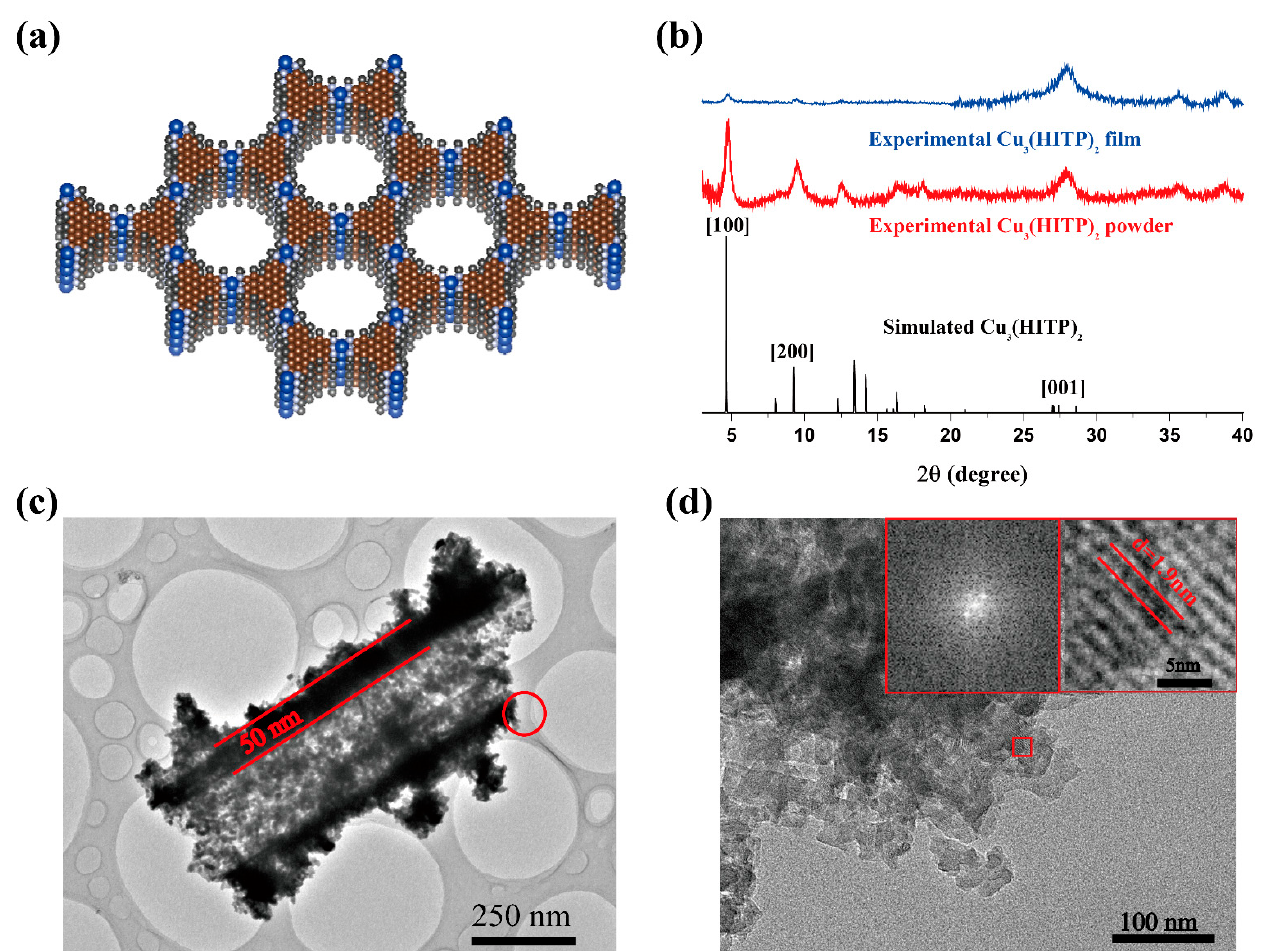
Figure 4. ( a ) Structure of Cu 3 (HITP) 2 viewed down the c-axis (brown: carbon, black: hydrogen, gray: nitrogen, blue: copper). ( b ) XRD pattern of simulated (black) and experimental Cu 3 (HITP) 2 powder (red) and PDMS-PCDA/Cu 3 (HITP) 2 NFAs (blue). ( c ) TEM images of PDMS-PCDA/Cu 3 (HITP) 2 NFAs. ( d ) HR-TEM (corresponding red circle in ( c )) and FFT patterns (corresponding red box in ( d )) of PDMS-PCDA/Cu 3 (HITP) 2 NFAs.